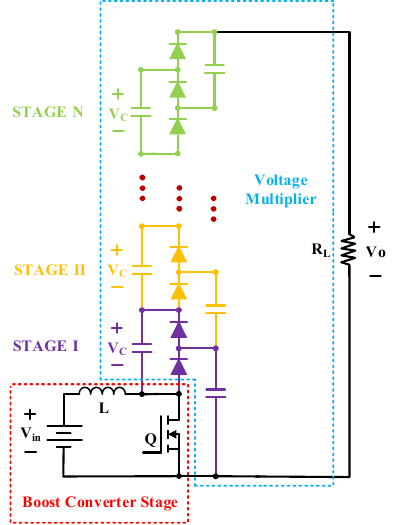
Figure 14. Hybrid voltage multiplier boost converter.